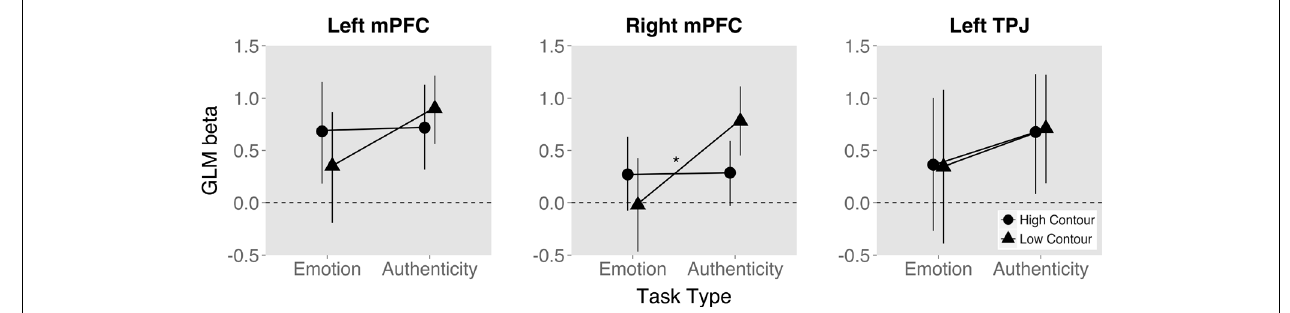
FIGURE 6 | Mean and 95% confidence interval of BOLD signal measure (GLM beta value) by task type and trial stimulus fundamental frequency contour value. Measures from three regions of interest selected from study 2 and extracted within study 1. (* p <